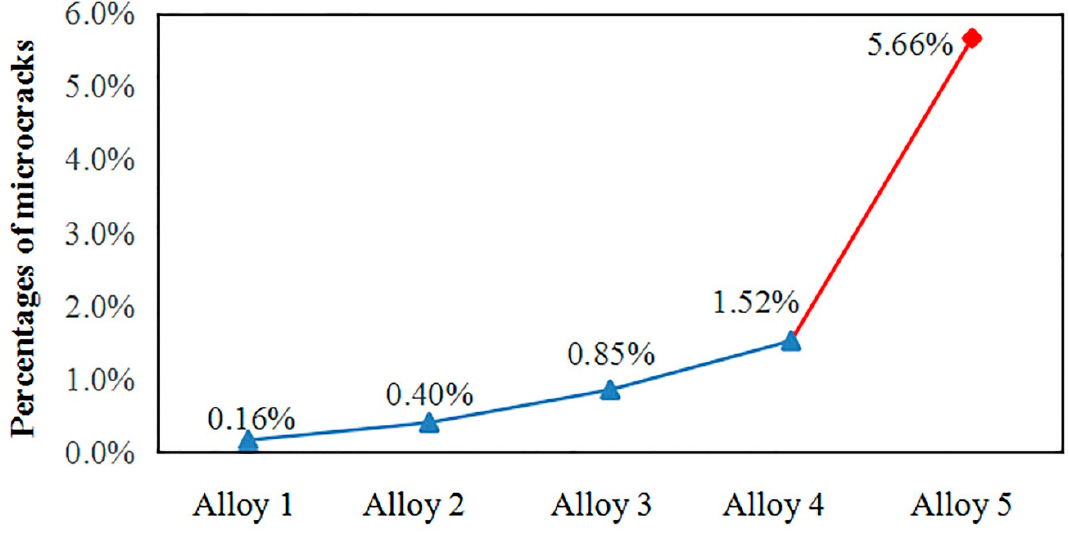
Figure 9. Percentages of micro-cracks in the